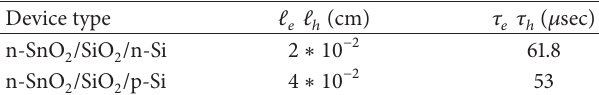
Table 1: The obtained results from the minority carrier life